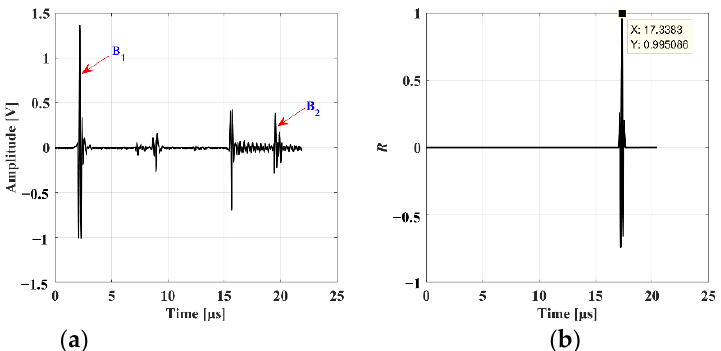
Figure 6. The correlation calculation result of an actual received ultrasonic signal: ( a ) the ultrasonic echo signal; ( b ) the correlation coefficient distribution.